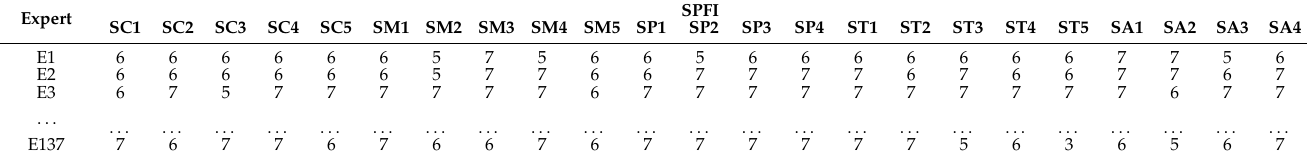
Table 7. Selective expressions on the importance to the safety of each safety philosophical factors’ indicator (SPFIs).